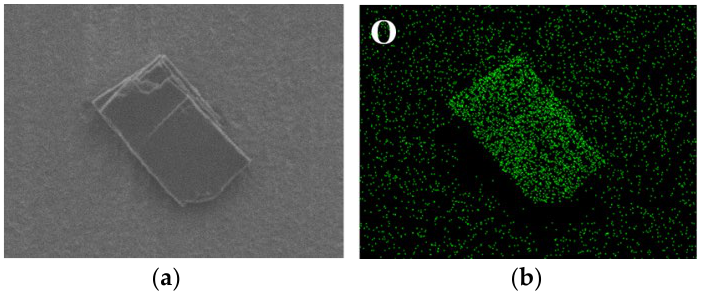
Figure 9. Elements distributions of the surface of tungsten in ultrapure water for 60 days. (( a ) is the SEM image; ( b ) is the mapping of O element.).